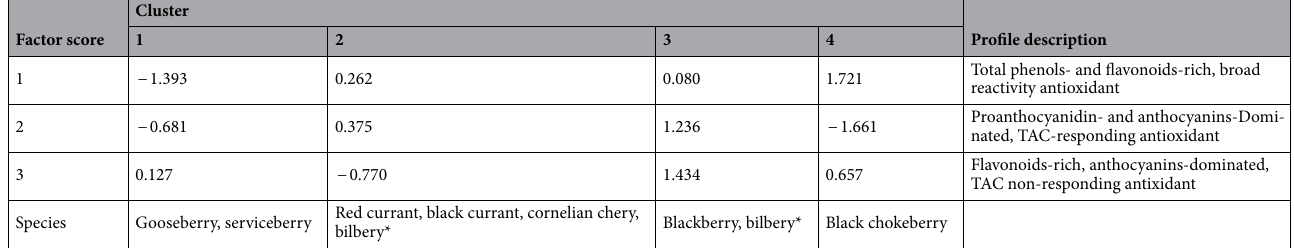
Table 5. Final cluster centers, species in clusters, and profiles description. *Bilberry samples split into two